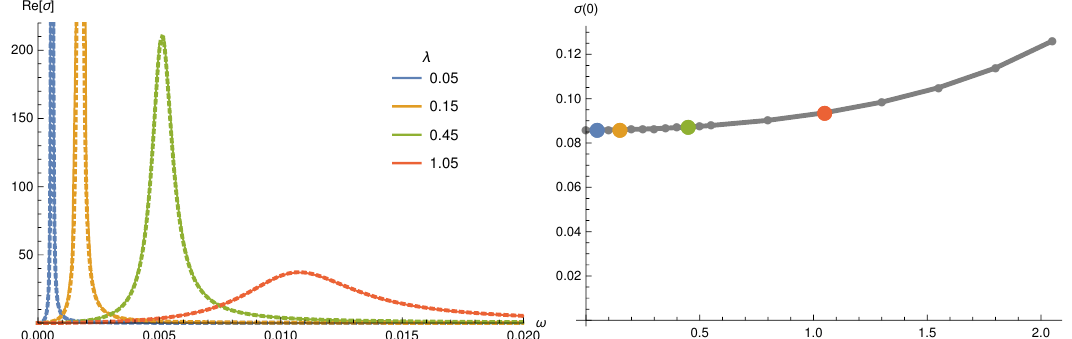
Figure 6 . AC conductivity (Left panel) and its limit at zero frequency (Right panel) in the state with fully developed spontaneous structure ( T = 0 : 52 T c ) as at di(cid:11)erent amplitudes of the explicit helix (cid:21) . The dashed lines show the prediction of (1.2) with parameters extracted from QNM spectrum. The solid lines are the numerical results. Color dots on the right panel mark the parameters for which the AC curves has been